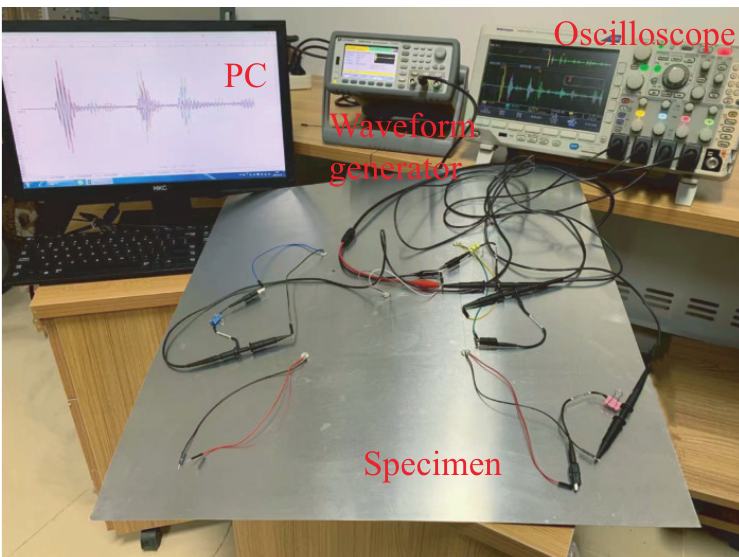
Figure 3. Experimental setup.